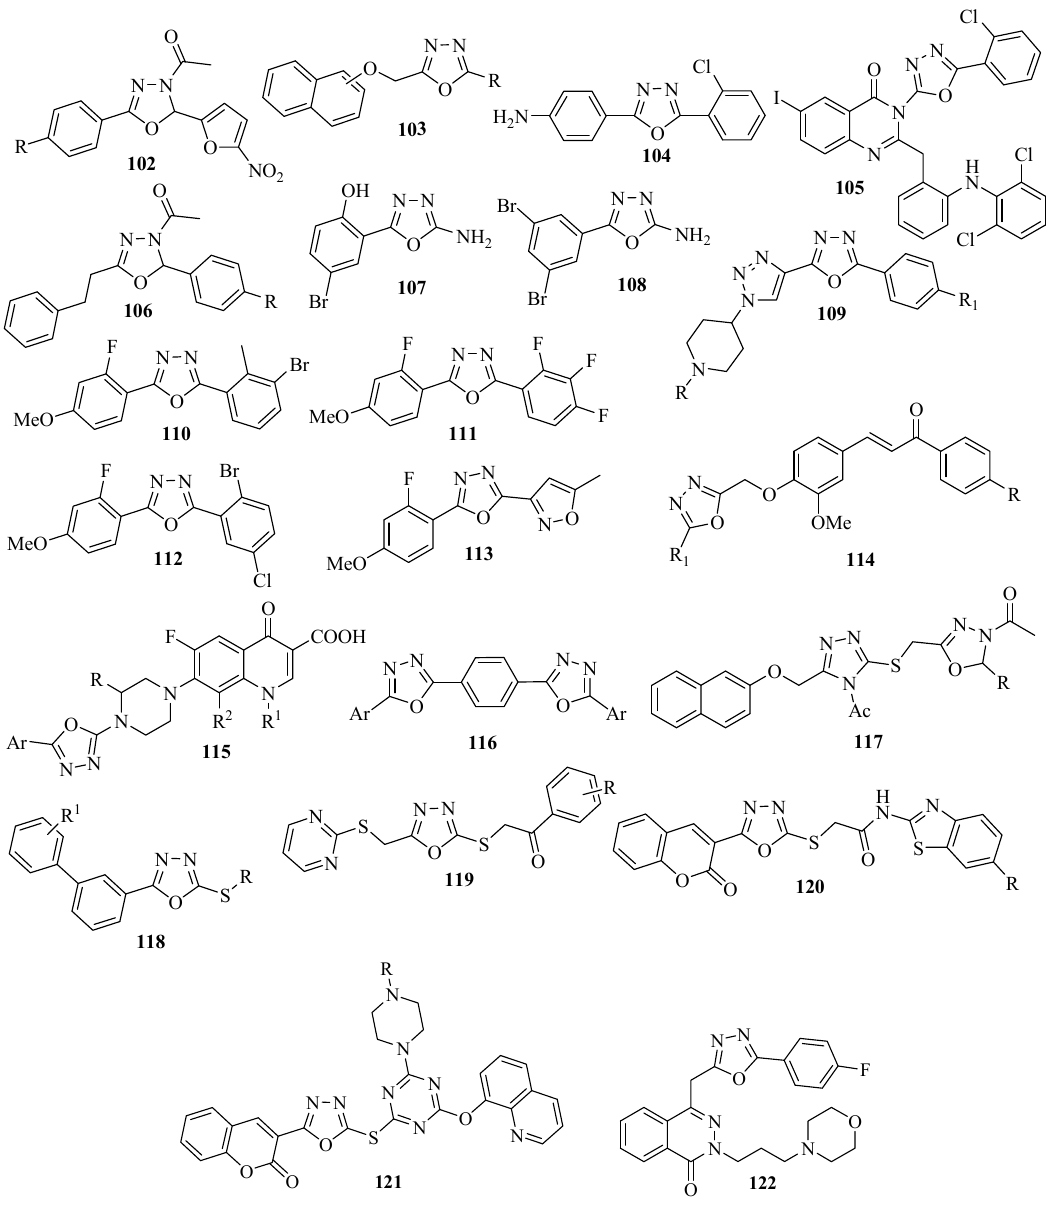
Figure 5. Disubstituted-1,3,4-oxadiazoles with antibacterial and antifungal